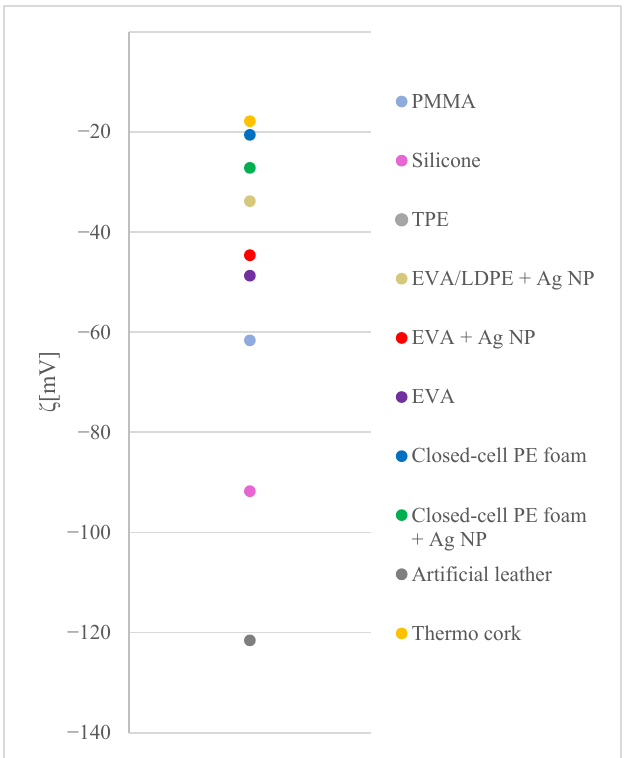
Figure 3. Zeta potentials of orthotic and prosthetic material surfaces.